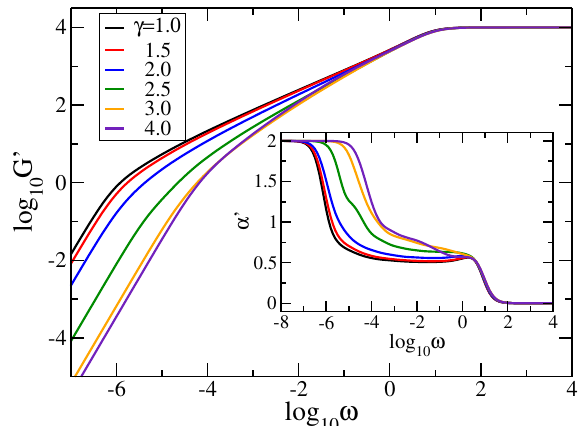
Figure 3. Storage modulus and the corresponding derivative (inset) for rDSFNs ( p = 0.0) with N = 10,000 and various values of γ . The frequency ω has units of σ = K / ζ